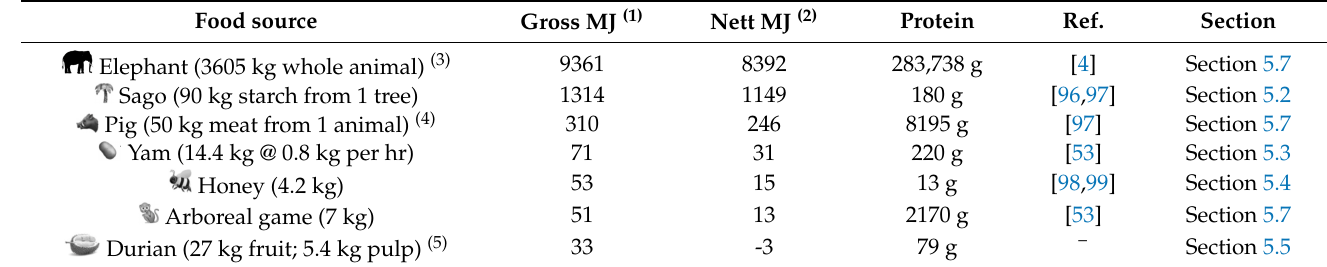
Table 5. Alternative food returns for one day’s effort for a family of foragers. (1) Gross energy (MJ) is the caloric value of the processed substance calculated using the USDA Food Composition Data- base <ndb.nal.usda.gov, 5 September 2018>, using “tapioca, pearl, dry” (cassava) for sago; “pork, fresh, loin, centre loin (chops), bone-in, separable lean and fat, cooked, broiled” for pig; “yam, raw” for yam; “honey”; “game meat, squirrel, cooked, roasted” for arboreal game; and “durian, raw or frozen”. (2) Caloric yield (MJ) net of acquisition and processing costs (for one day with three adults spending six hours of effort each, plus their basal metabolic rate (BMR); i.e., 18 h of work and 72 h BMR = 32.7 MJ) and the thermic effect of food (estimated here at 10% of the gross caloric value). (3) We adjusted the figures that [4] give for Elephas antiquus , noting that they use fat-to-protein ratios based on the buffalo. (4) Refers to a moderately fat Sus barbatus . (5) Assuming 18 fruit @1.5 kg each; net caloric values for durian are negative assuming three person-days’ foraging effort to obtain them; however, in practice, there is the option of camping next to the fruiting trees and incurring minimal effort, although this increases the risk of encountering elephants.